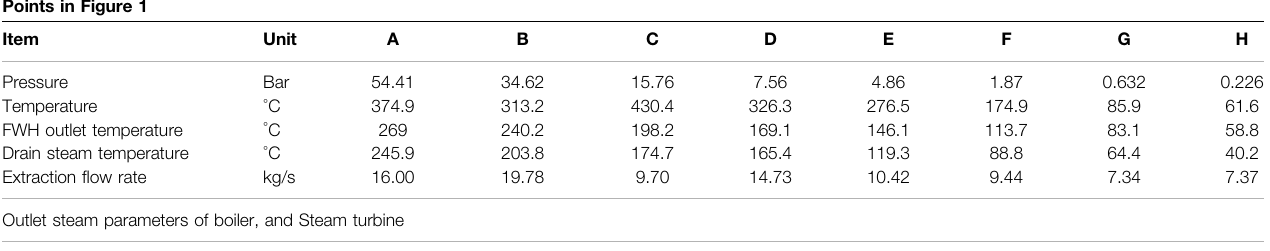
TABLE 2 | Key parameters of case study power plant (300 MW subcritical power plants). Points in Figure 1 Item